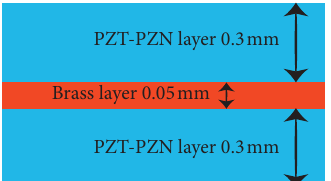
Figure 8: The thickness view of the composite two-piece trape- zoidal beam’s upper and lower PZT-PZN-Scheme 4 layer thickness for both two bimorph designs. The length of the beam L is 60mm, the thickness of T piezo is 0.3mm, and the thickness of the brass layer T s is 0.05 mm.